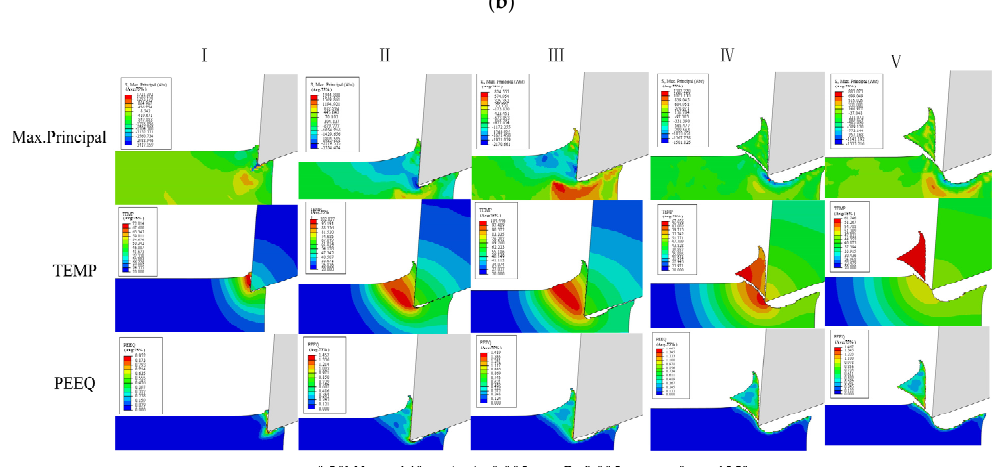
Figure 11. Analysis of UEVC material removal process (Max.Principal- Maximum Principal Stress, PEEQ- Plastic Strain). ( a ) Phase difference 45°; ( b ) phase difference 90°; ( c ) phase difference 135°.